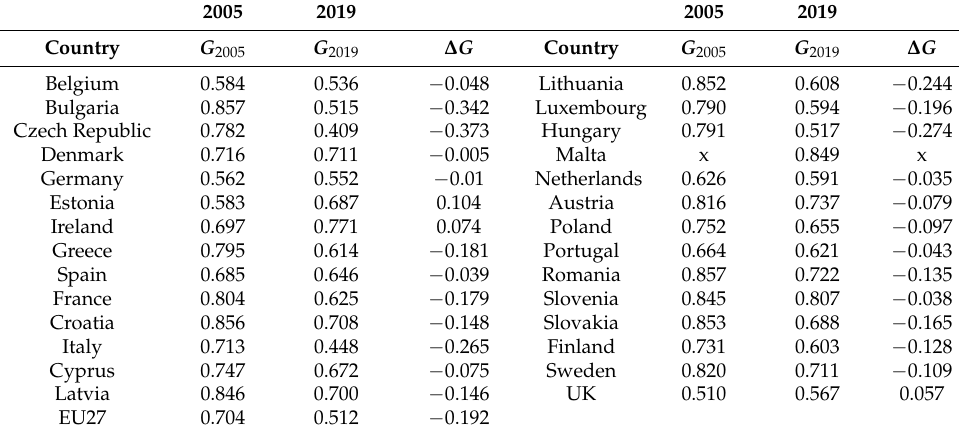
Table 3. Concentration of types of sources in the production of electricity from renewable sources in the EU countries—the values of Gini